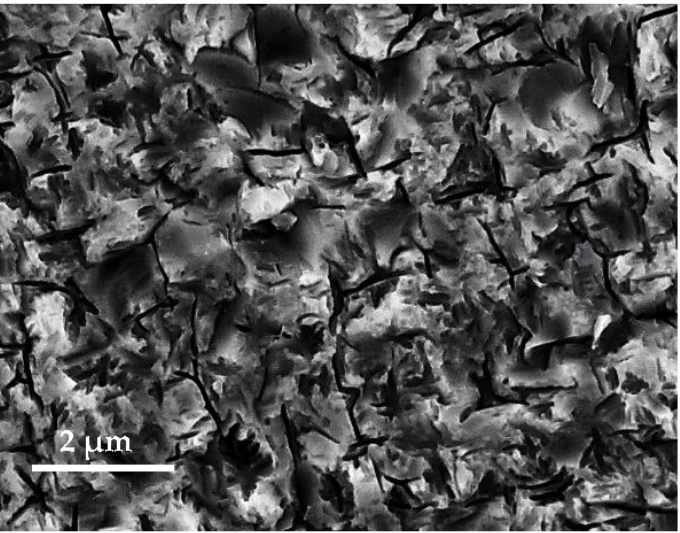
Figure 3. Top-view FESEM image showing the morphology of the created porous sacrificial layer, showing a nanostructured GaAs surface that was made at both sides.